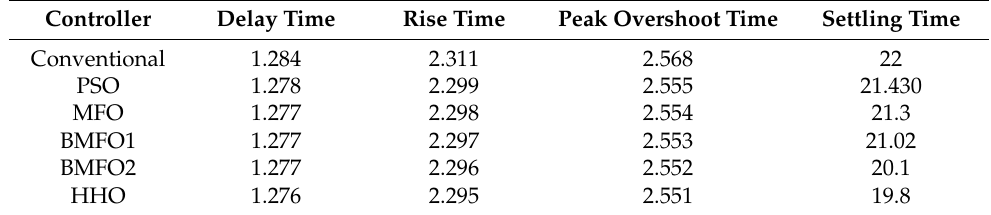
Table 12. Graph analysis of deviation in tie-line error with various controller under bilateral contract. Controller